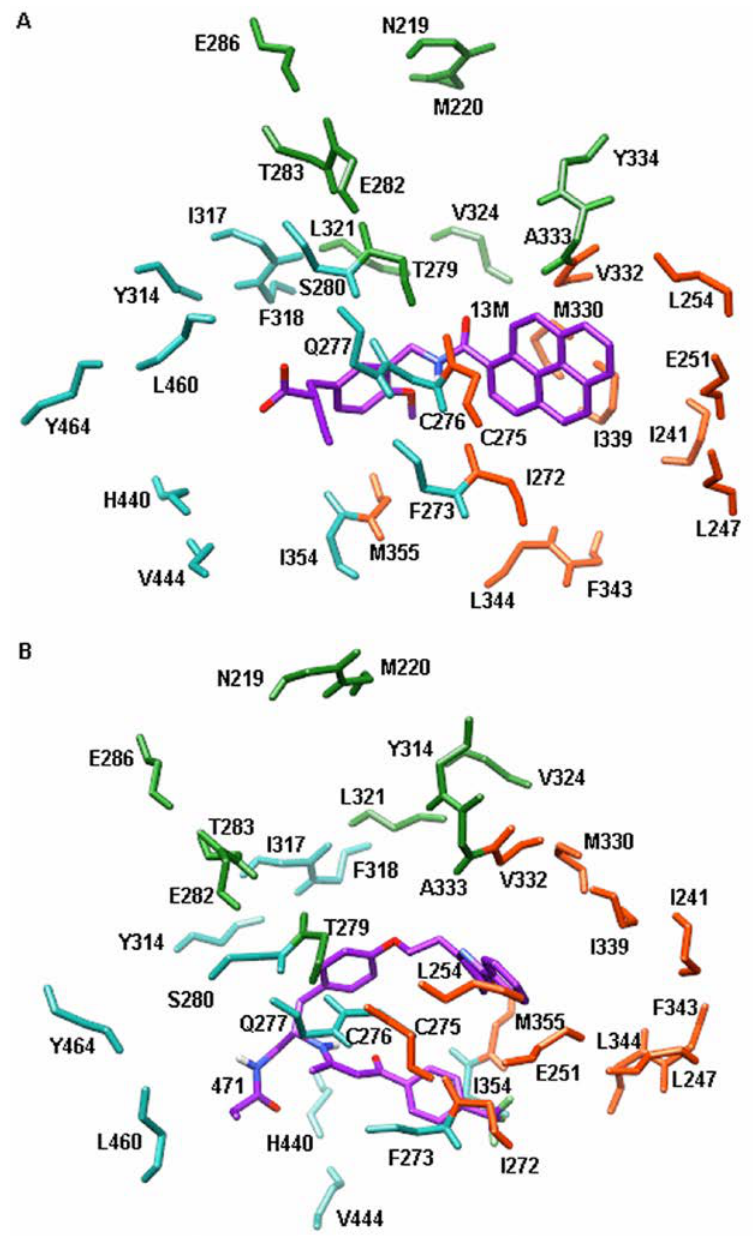
Figure 2. The active site of PPAR-α. ( A ) PPAR-α/13M complex; and ( B ) PPAR-α/471 complex. Residues in PPAR-α are only shown with backbone atoms. Agonist and antagonist are shown in stick with purple carbon atoms. The arm I region is shown in stick with blue atoms. The arm II region is shown in stick with orange atoms. The entrance region is shown in stick with green atoms. For the sake of clarity, only the polar hydrogen atoms are